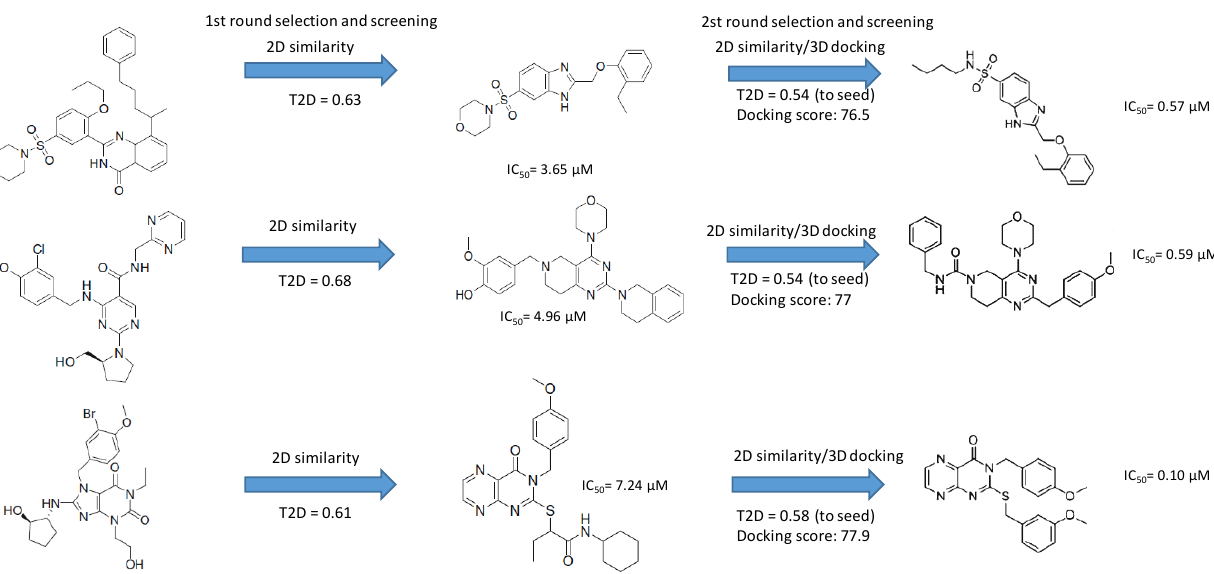
17 of 31 Figure 10. Parallel integration workflow for identification of PDE5 inhibitors.